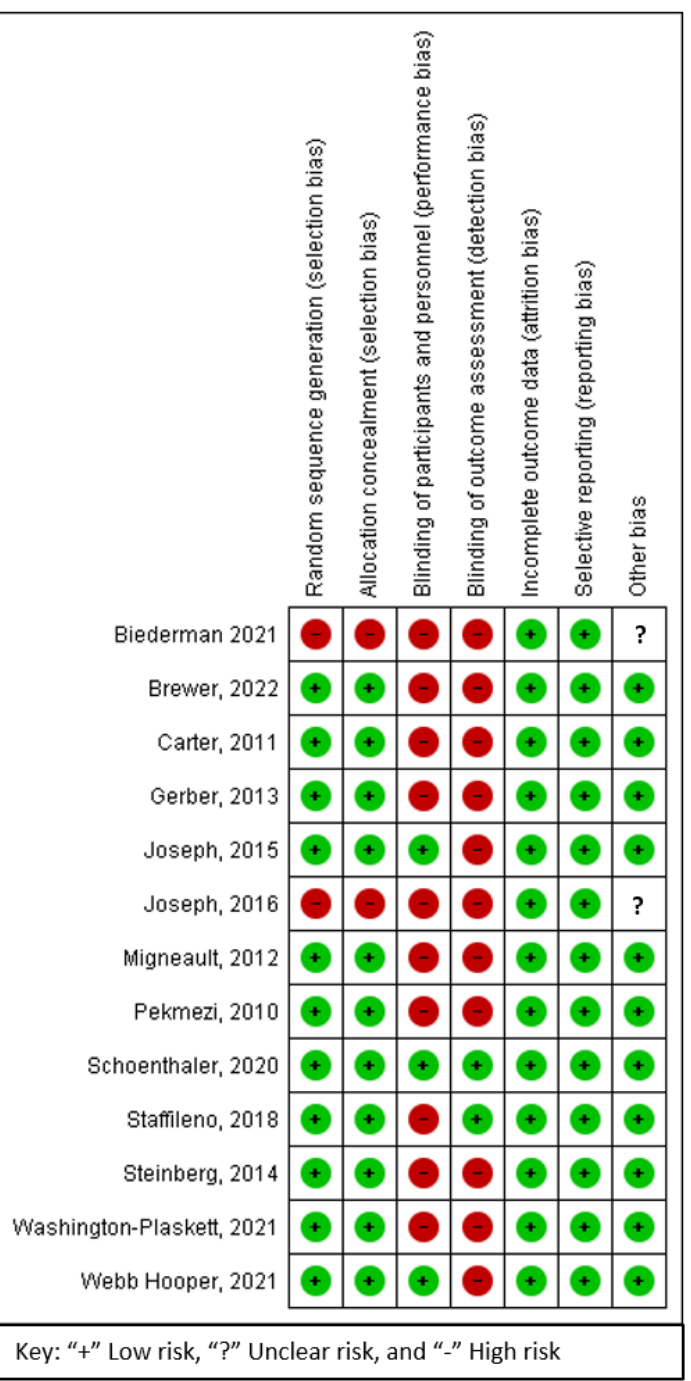
Figure 2. Summary of Reviewers’ Assessments of Each Study’s Risk of Bias [43–55].